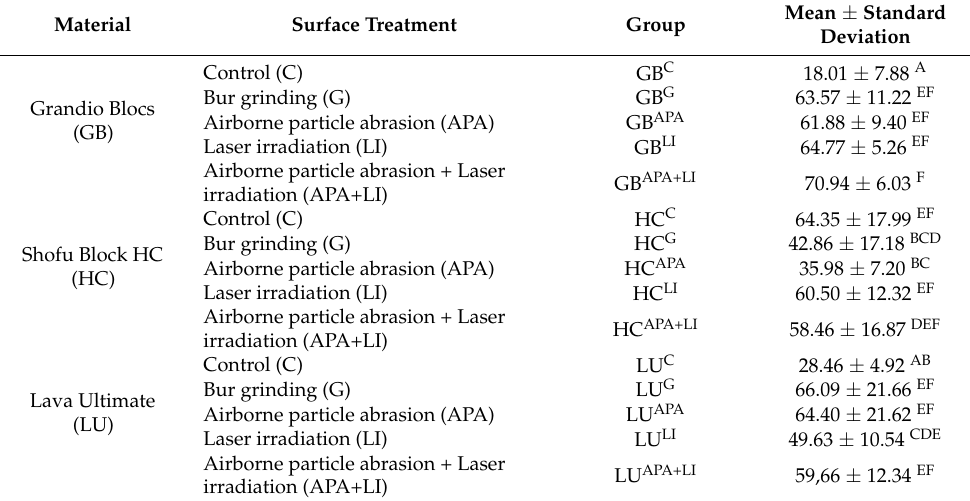
Table 3. Mean microtensile bond strength (MPa) and ± standard deviation data according to the factors “material” and “surface